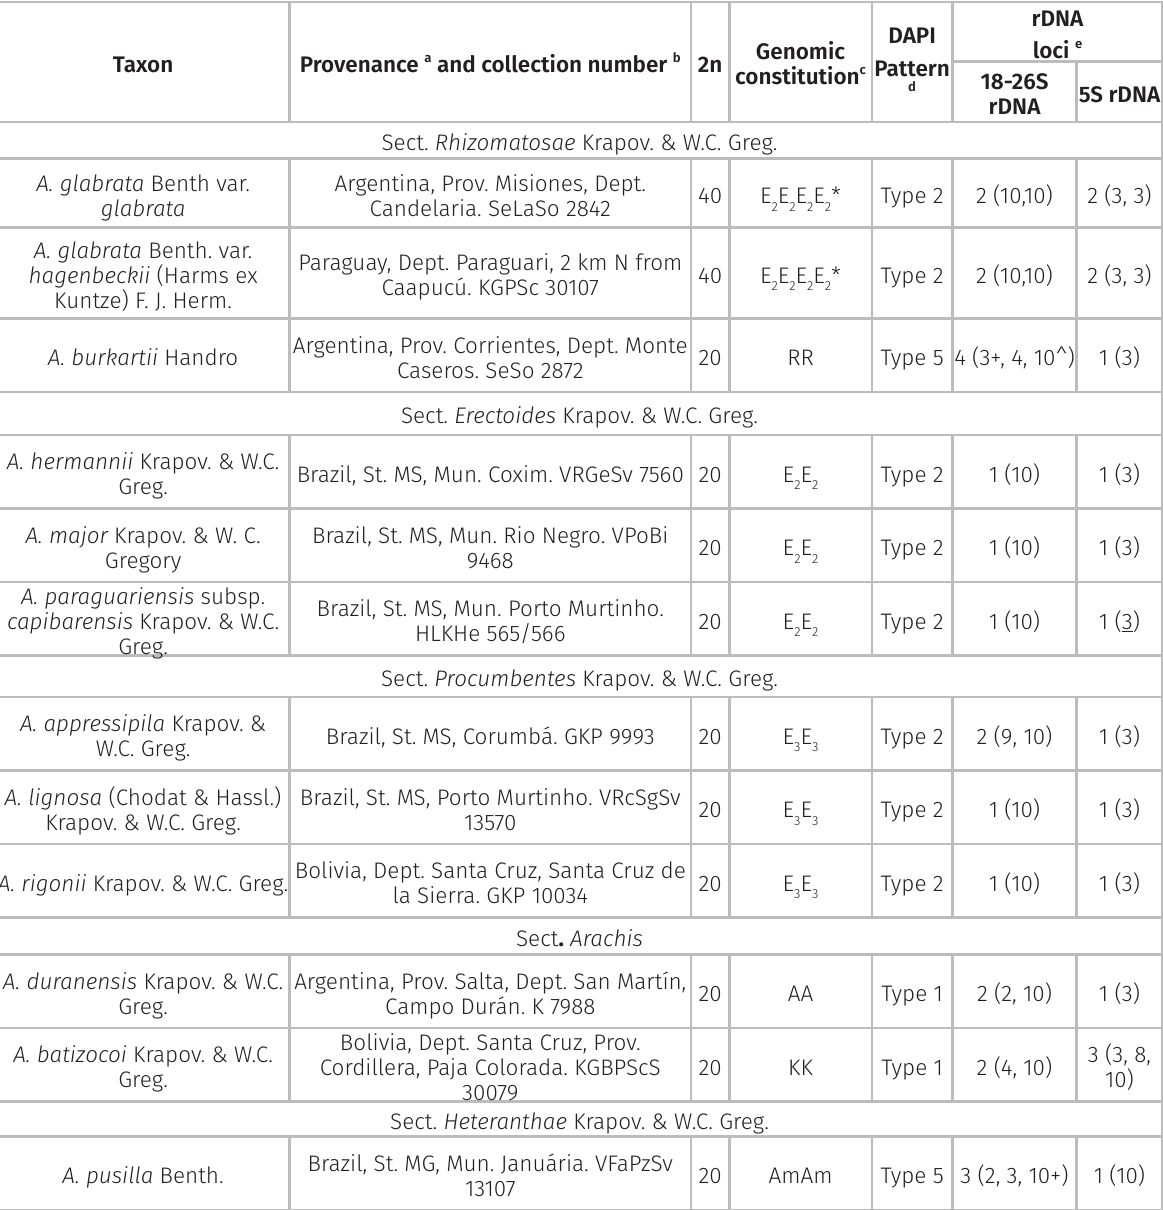
Table I. List of the Arachis species and samples studied, their provenance, chromosome number, genome formula, type of DAPI pattern and number of ribosomal loci (rDNA). Species are ordered first by ploidy level and then by genomic